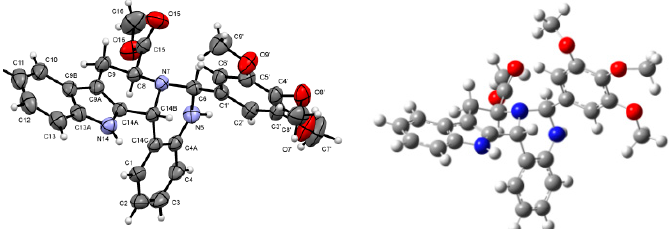
Figure 2. Stereostructure of trans pentacyclic esther 9f / T1 obtained by single crystal X-ray diffraction (left) and DFT modelling (right).